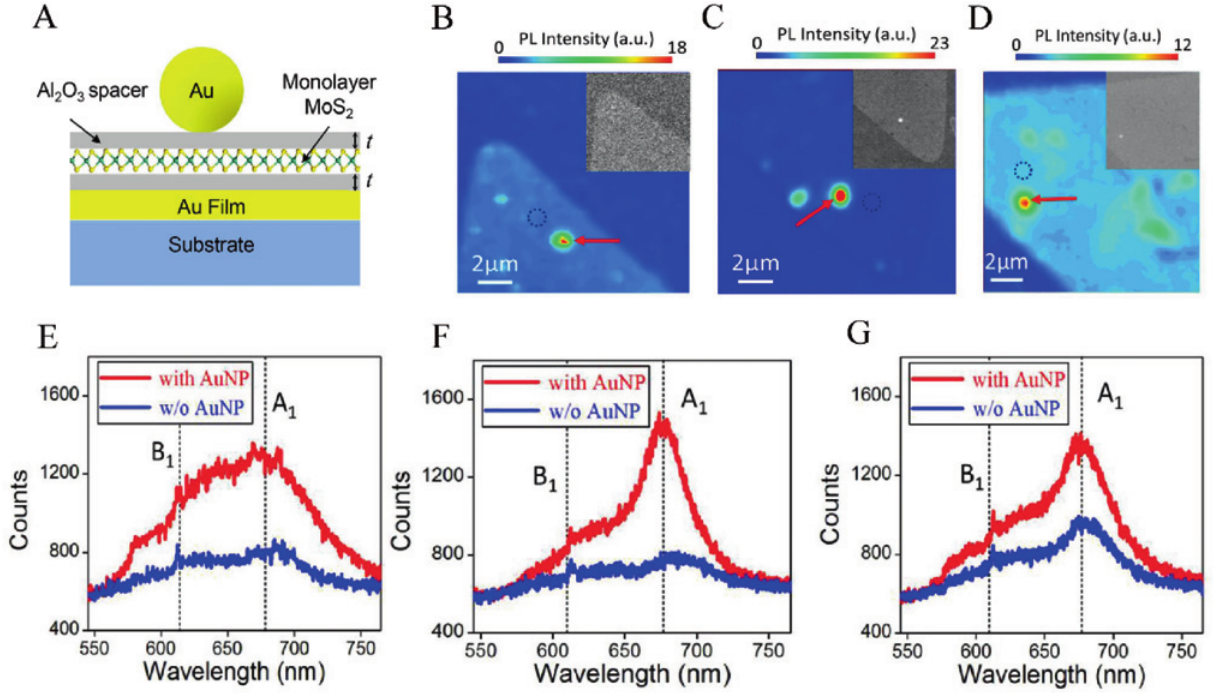
Figure 2: (A) Schematic representation of AuNP – AuFilm coupled system with Al 2 O 3 spacers. (B – D) PL intensity maps of monolayer MoS 2 samples.Insets:SEMimageofeachsampletype.Thethicknessofthespaceris(B)3nm(C)5nm(D)7nm.(E – G)PLspectraofmonolayerMoS 2 with and without AuNPs (red and blue curves), corresponding to the position in (B – D) (red arrow and black dashed circle, respectively).